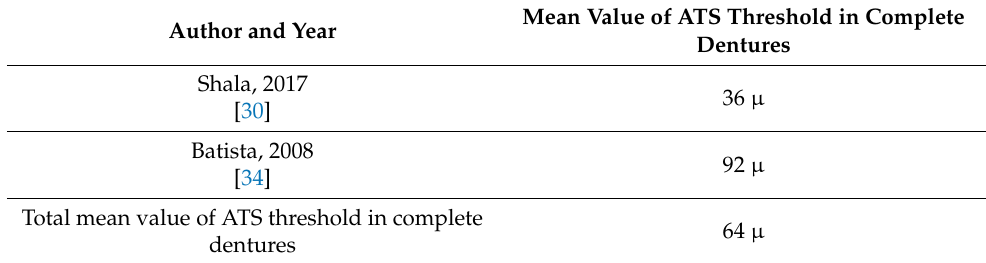
Table 4. ATS thresholds in complete dentures.